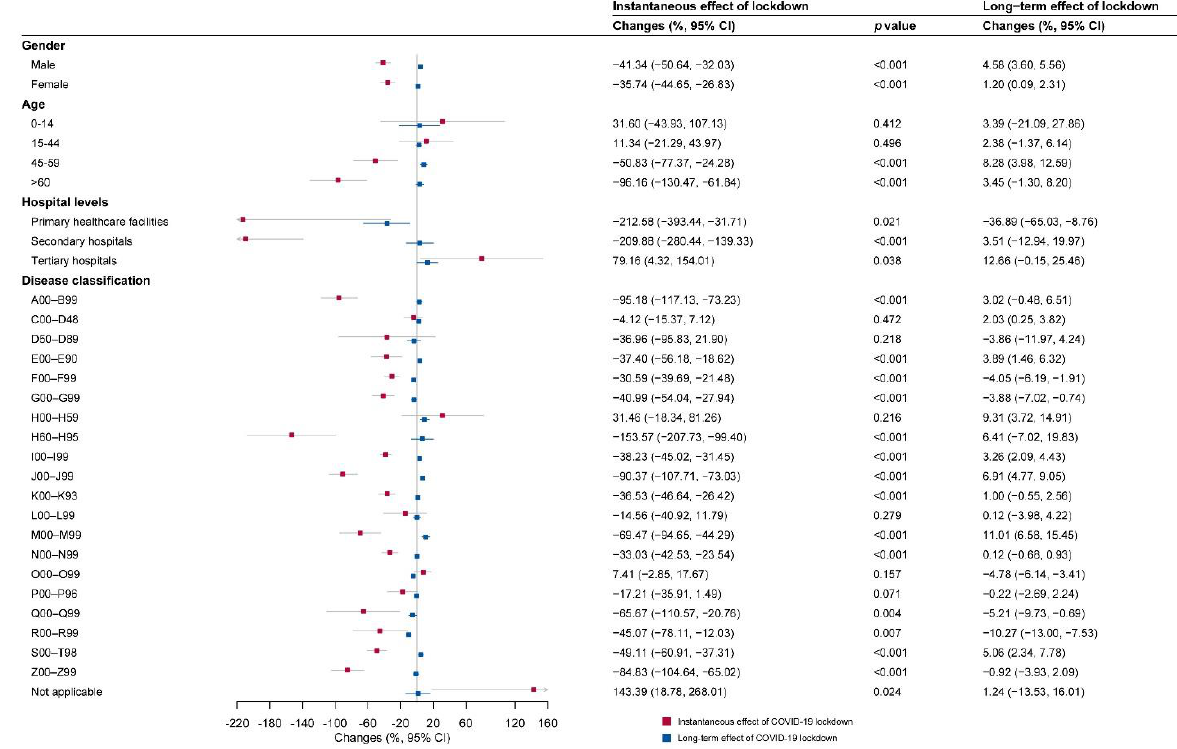
Figure 6. The instantaneous and long-term effect of COVID-19 lockdown on hospital visits within